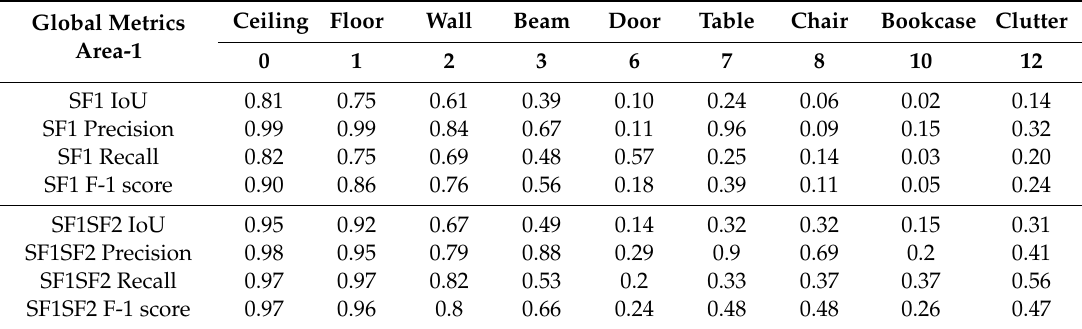
Table 8. Global per-class metrics concerning the Area-1 of the S3DIS dataset. SF1 alone and combined SF1SF2 are